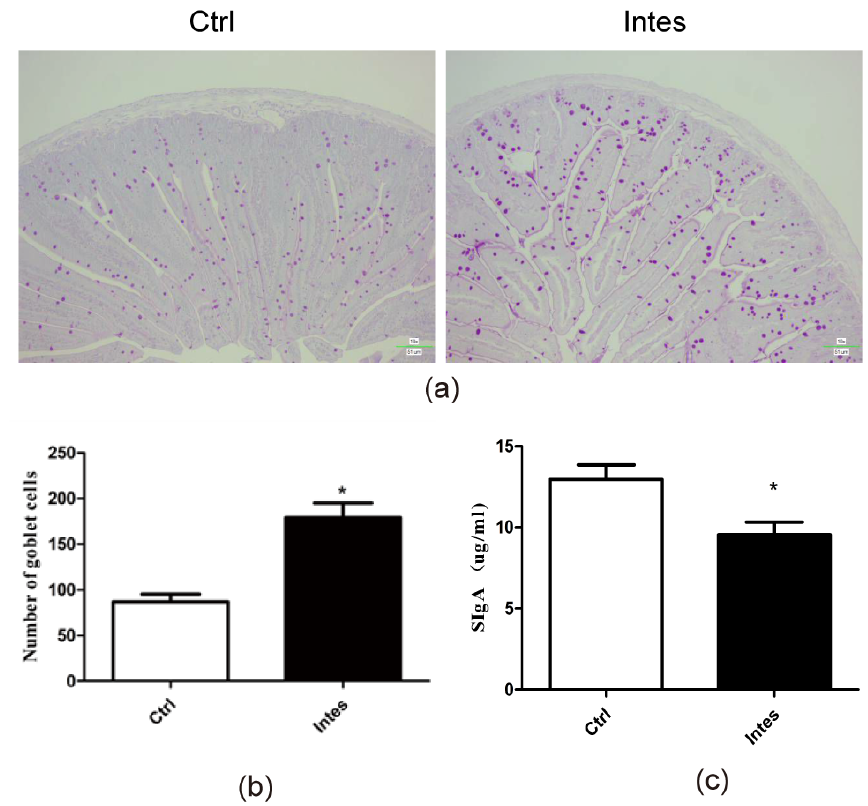
Figure 8. Mice with intestinal flora disorders showed more severe intestinal barrier damage ( a ). PAS staining of jejunum goblet cells in the gut microbiota dysbiosis model ( b ). Column graphs represent quantified goblet cell content ( c ). Jejunum sIgA content in the gut microbiota dysbiosis model. * p < 0.05 as compared to the Ctrl group.